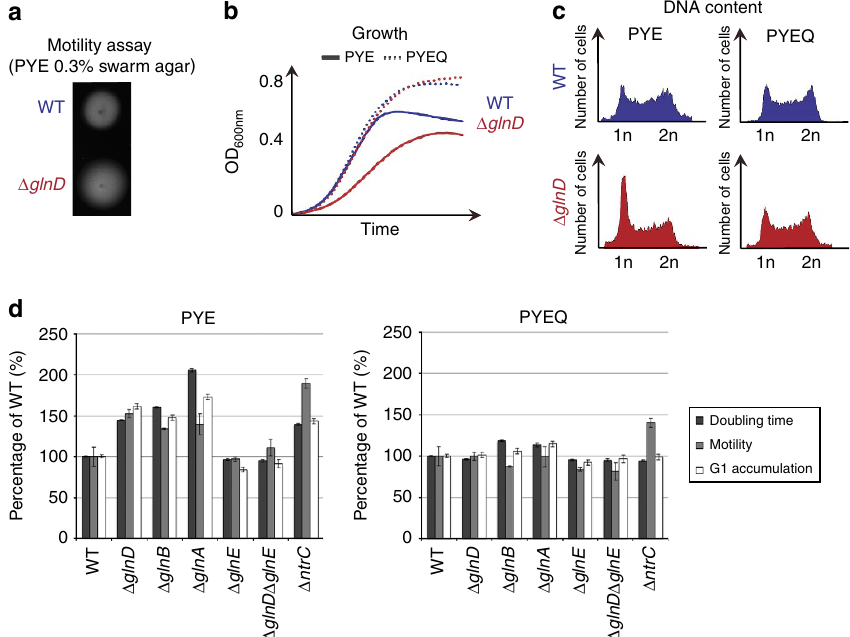
Figure 2 | The C. crescentus G1/swarmer cell lifetime is dictated by intracellular glutamine concentration. ( a – d ) Extension of the G1/swarmer lifetime in a D glnD strain can be compensated by addition of glutamine. Motility ( a ), growth ( b ) and DNA content ( c ) of wild-type (WT; RH50) and D glnD (RH577) grown in complex media without (PYE) or with glutamine (PYEQ) media. ( d ) G1/swarmer lifetime is extended in glutamine auxotrophic mutants. Doubling time, motility and G1 proportion were measured in WT (RH50), D glnD (RH577), D glnB (RH771), D glnA (RH772), D glnE (RH874), D glnD D glnE (RH875) and D ntrC (RH1458) grown in complex media without (PYE) or with glutamine (PYEQ), and normalized to the WT (100%). All these phenotypes can be rescued by addition of glutamine (PYEQ). Error bars ¼ s.d.; n ¼ 3. NATURE COMMUNICATIONS|7:11423|DOI: